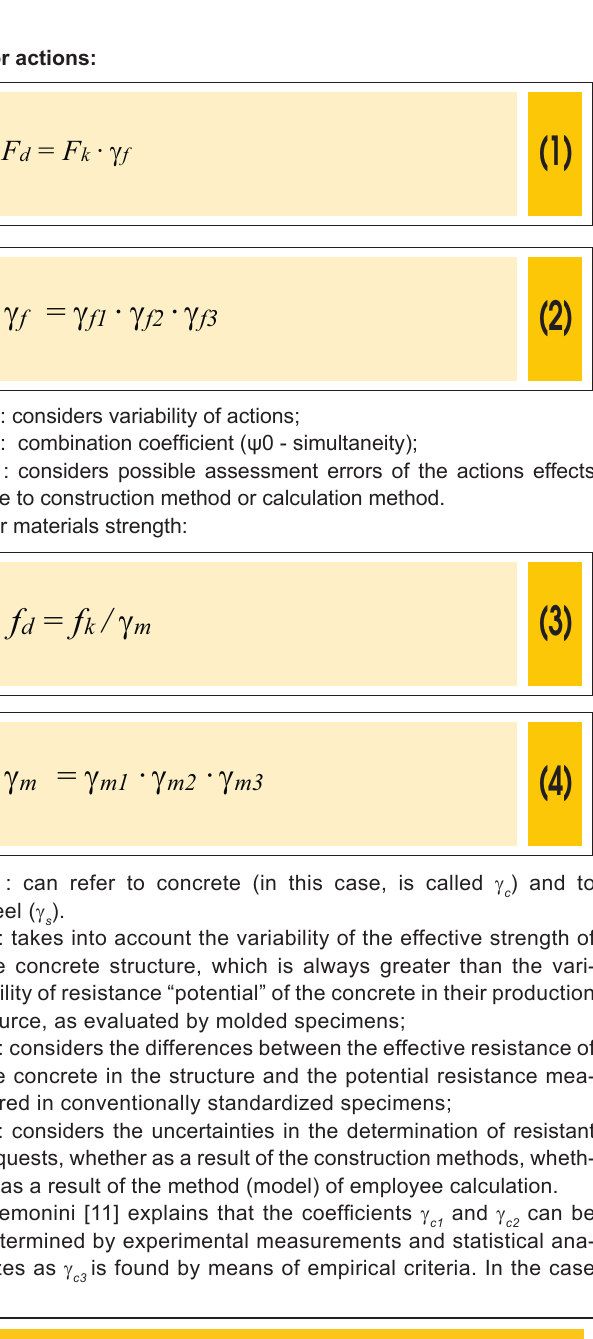
Table 2 – Strength reduction factors utilized for design of new